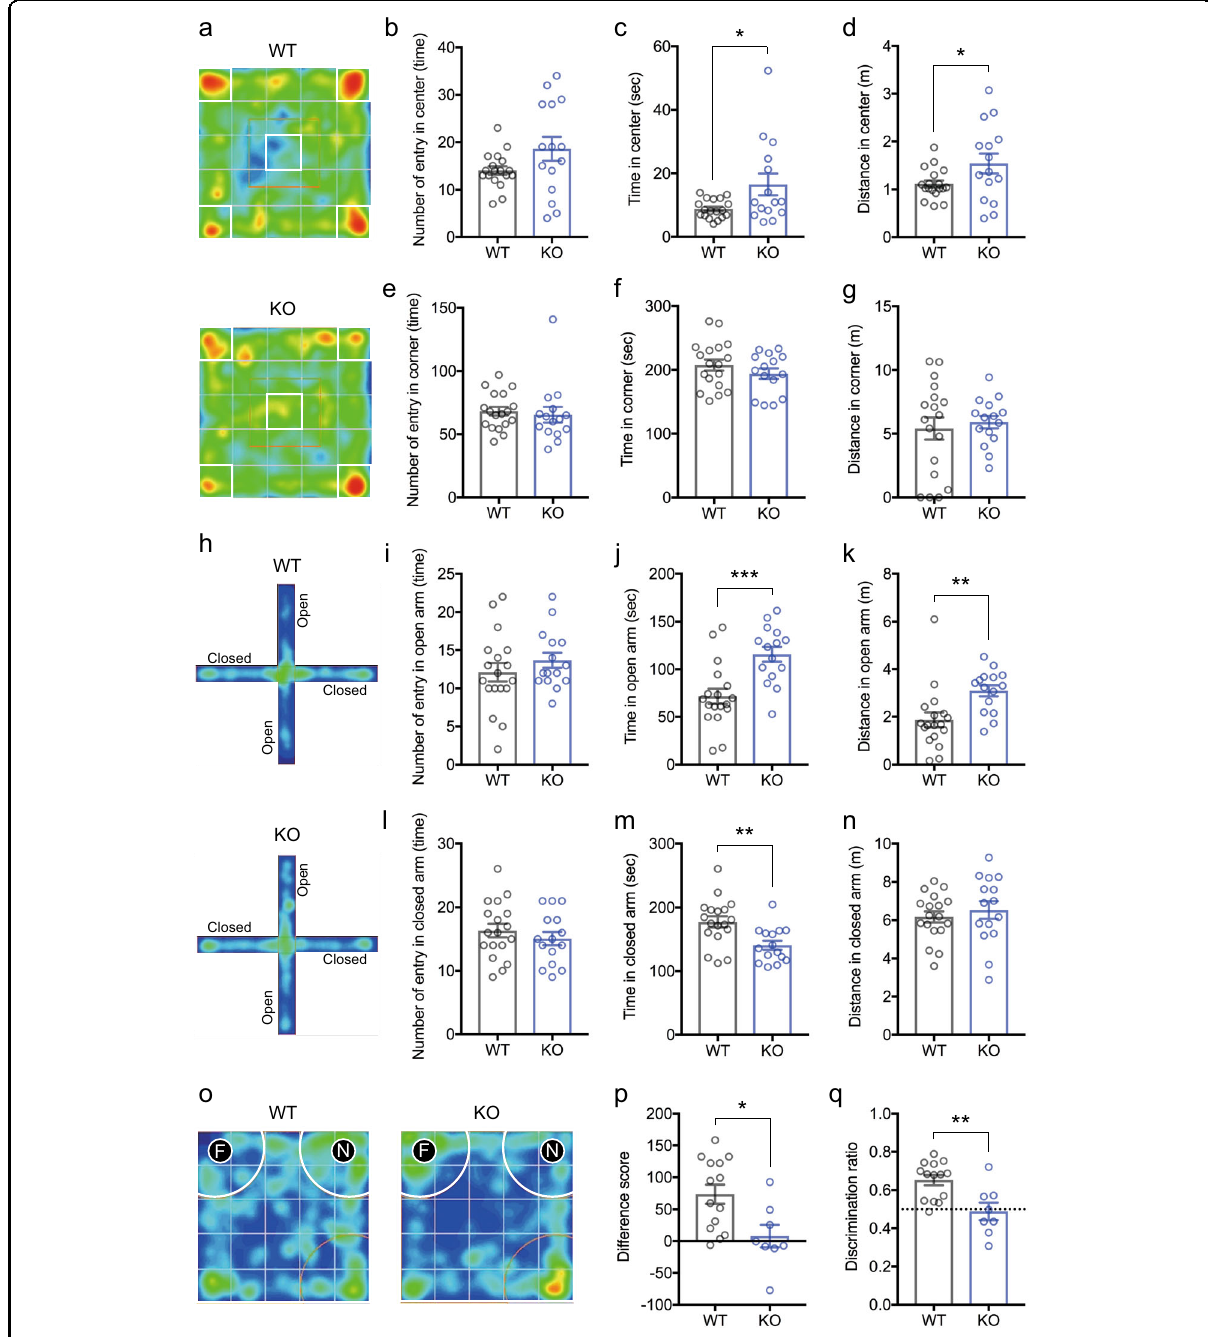
Fig. 2 Zbtb16 KO mice show risk-taking behaviors due to cognitive impairment. a Representative heatmaps of anxiety-like behavior in the open fi eld test. b – g Quanti fi cation of the number of entries in the center ( b ), time in the center ( c ), distance in the center ( d ), the number of entries in the corner ( e ), time in the corner ( f ), and distance in the corner ( g ) during the open fi eld test. Zbtb16 KO mice spent more time in the center than WT mice. h Representative heatmaps of anxiety-like behavior in the elevated plus-maze test. i – n Quanti fi cation of the number of entries in open arm ( i ), time in open arm ( j ), distance in open arm ( k ), the number of entries in the closed arm ( l ), time in the closed arm ( m ), and distance in the closed arm ( n ) during the elevated plus-maze test. Zbtb16 KO mice also spent more time in the open arm than the closed arm compared with WT mice, indicating that impulsive risk-taking behaviors were increased in Zbtb16 KO mice. o Representative heatmaps of learning and memory behaviors in the novel object recognition test. N : Novel mouse , F : familiar mouse . p , q Quanti fi cation of difference score ( p ) and discrimination ratio ( q ) in the novel object recognition test. Cognitive function was signi fi cantly impaired in Zbtb16 KO mice. A positive difference score or discrimination ratio >0.5 means a mouse recognizes the novel object. Data are represented as means (±SEM). Asterisks indicate *** P < 0.001, ** P < 0.01, * P < 0.05, unpaired t -test. n = 15 – 18/condition for open fi eld and elevated plus-maze tests, n = 8 – 14/condition for a novel object recognition